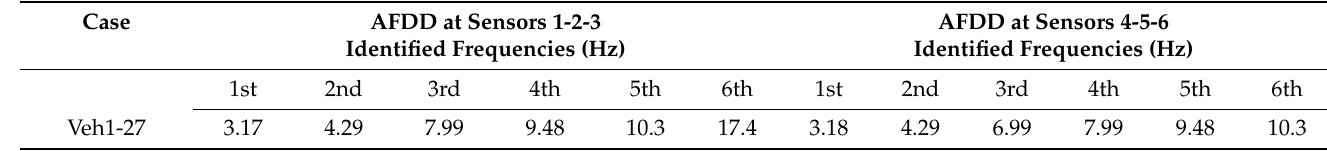
Table 15. Identified frequencies of numerical results with FDD method in the transverse direction (Y axis).